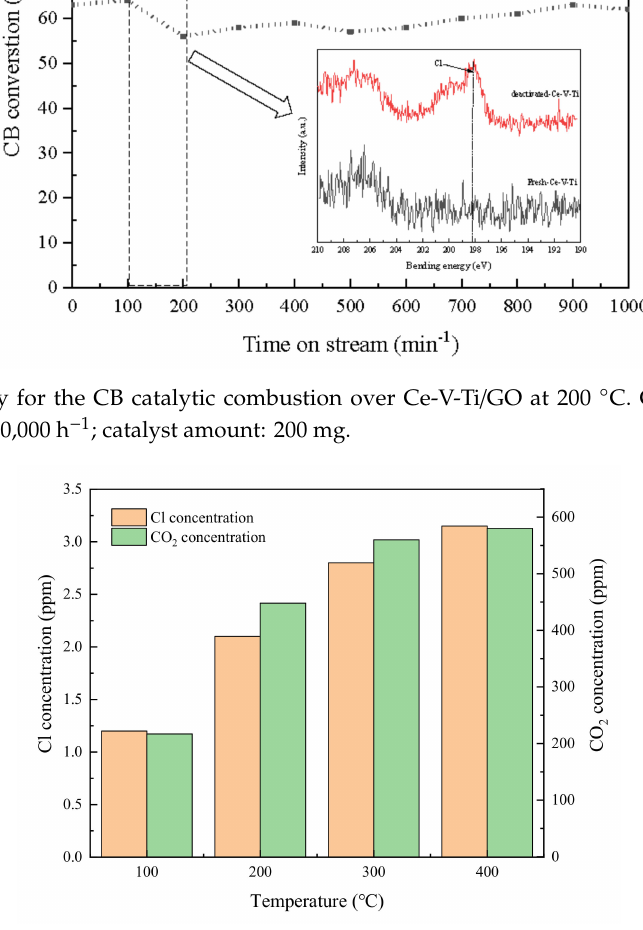
Figure 4. Main products of CB combustion over Ce-V / Ti-GO(0.7) catalysts. CB concentration: 100 ppm; GHSV: 30,000 h − 1 ; catalyst amount: 200